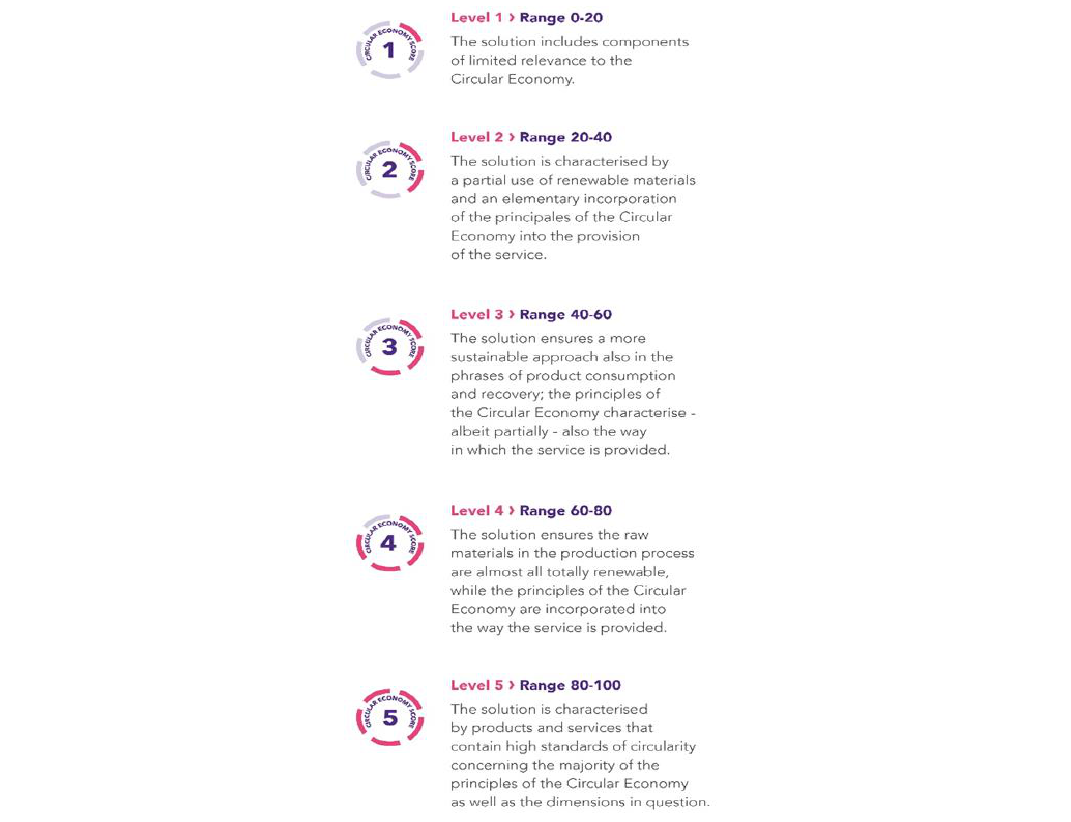
Figure 2: Circularity Scale